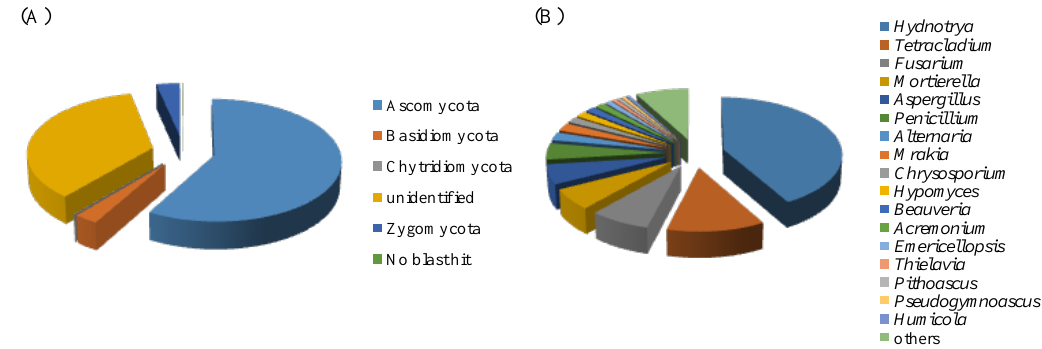
Figure 2. Soil fungal community composition on leaves, at phylum ( A ) and genus level ( B ).